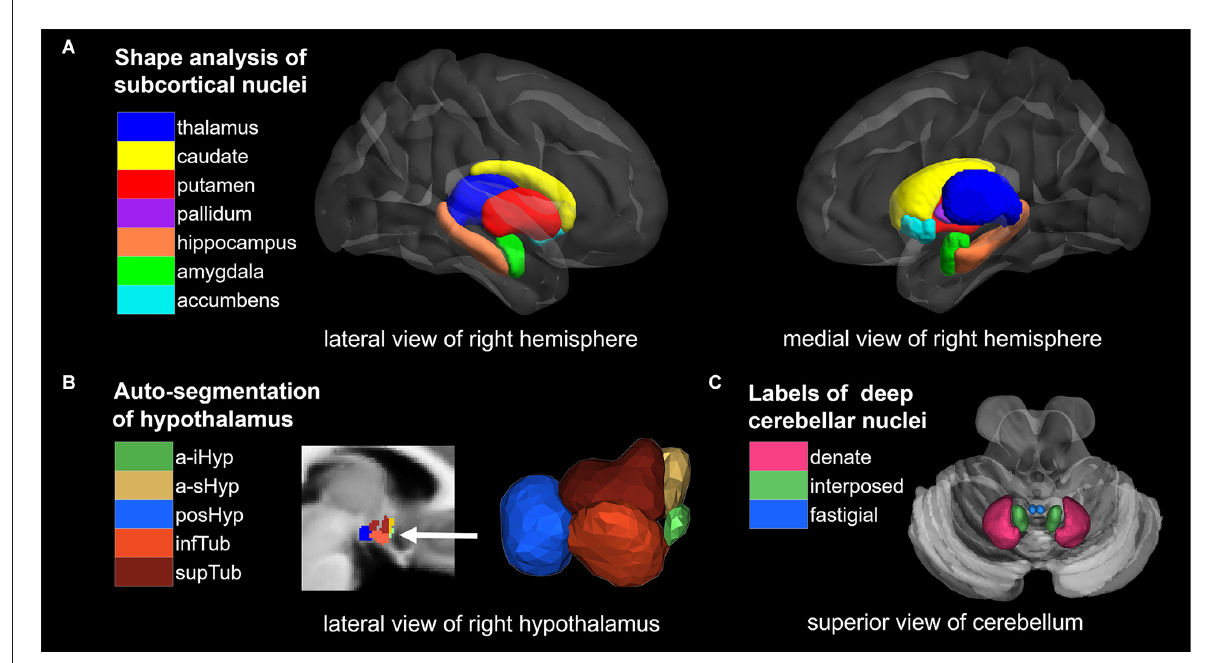
FIGURE1 Overview of segmentation methods and corresponding brain nuclei. (A) Shape analysis of subcortical nuclei. (B) Auto-segmentation of hypothalamus. (C) ROI analysis of deep cerebellar nuclei (DCN). NAc, nucleus accumbens; a-iHyp, anterior-inferior; a-sHyp, anterior-superior; posHyp, posterior; infTub, inferior tubular; supTub, superior